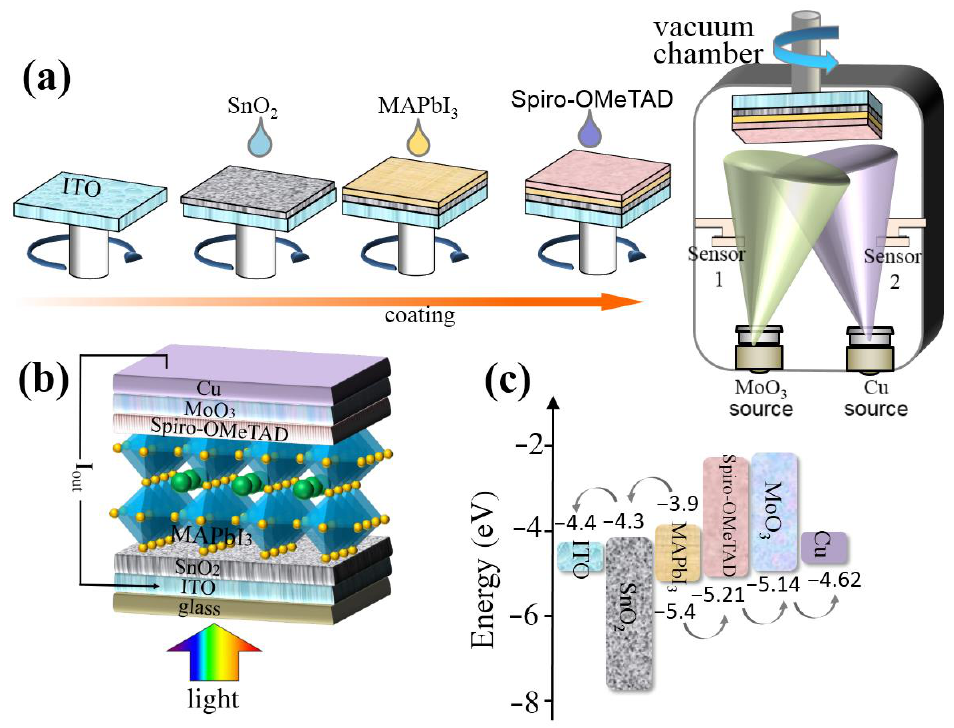
Figure 1. ( a ) The manufacturing process of PSCs. ( b ) The device configuration of PSCs. ( c ) Energy level diagram of PSCs.